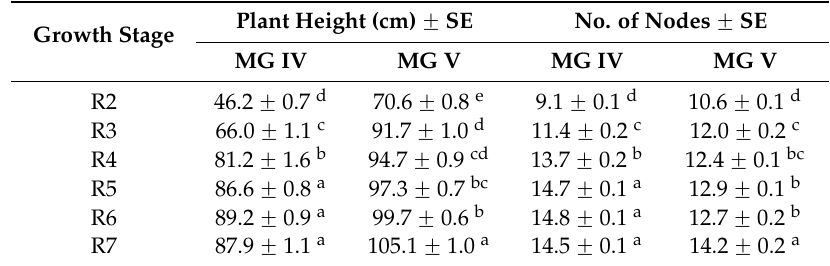
Table 1. Differences between soybean plant height and number of nodes during reproductive growth stages a .